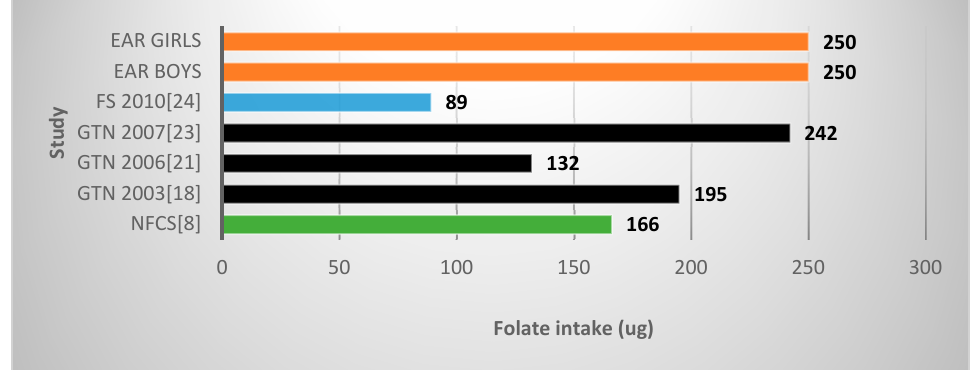
Figure 7. Mean folate intake in studies on schoolchildren in South Africa between 2000 and 2015 with the blue bars representing one study which included fortification values. EAR: estimated average intake; GTN: Gauteng; FS: Free State; NW: North West; NFCS: National Food Consumption Survey.